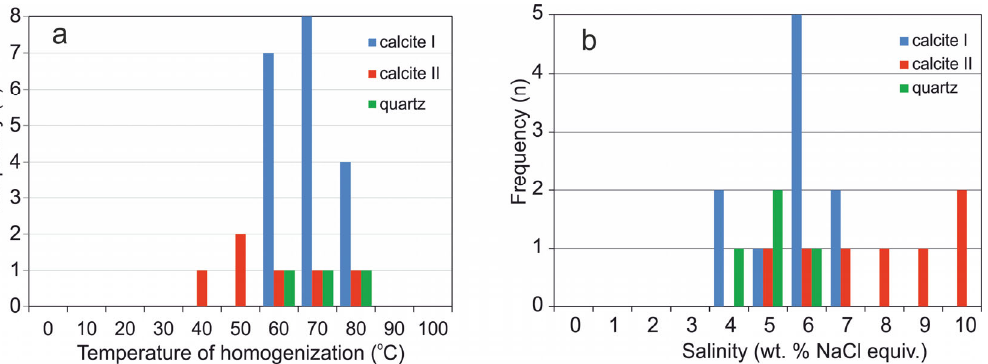
Figure 12. ( a ): Histograms of the temperatures of homogenization and ( b ): salinities of the fluid inclusions in the calcites and quartz.